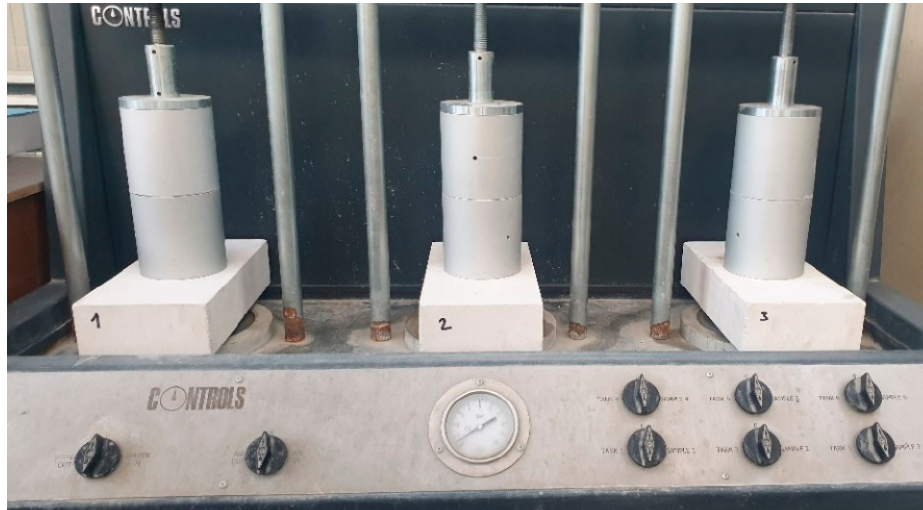
Figure 2. Water pressure test.